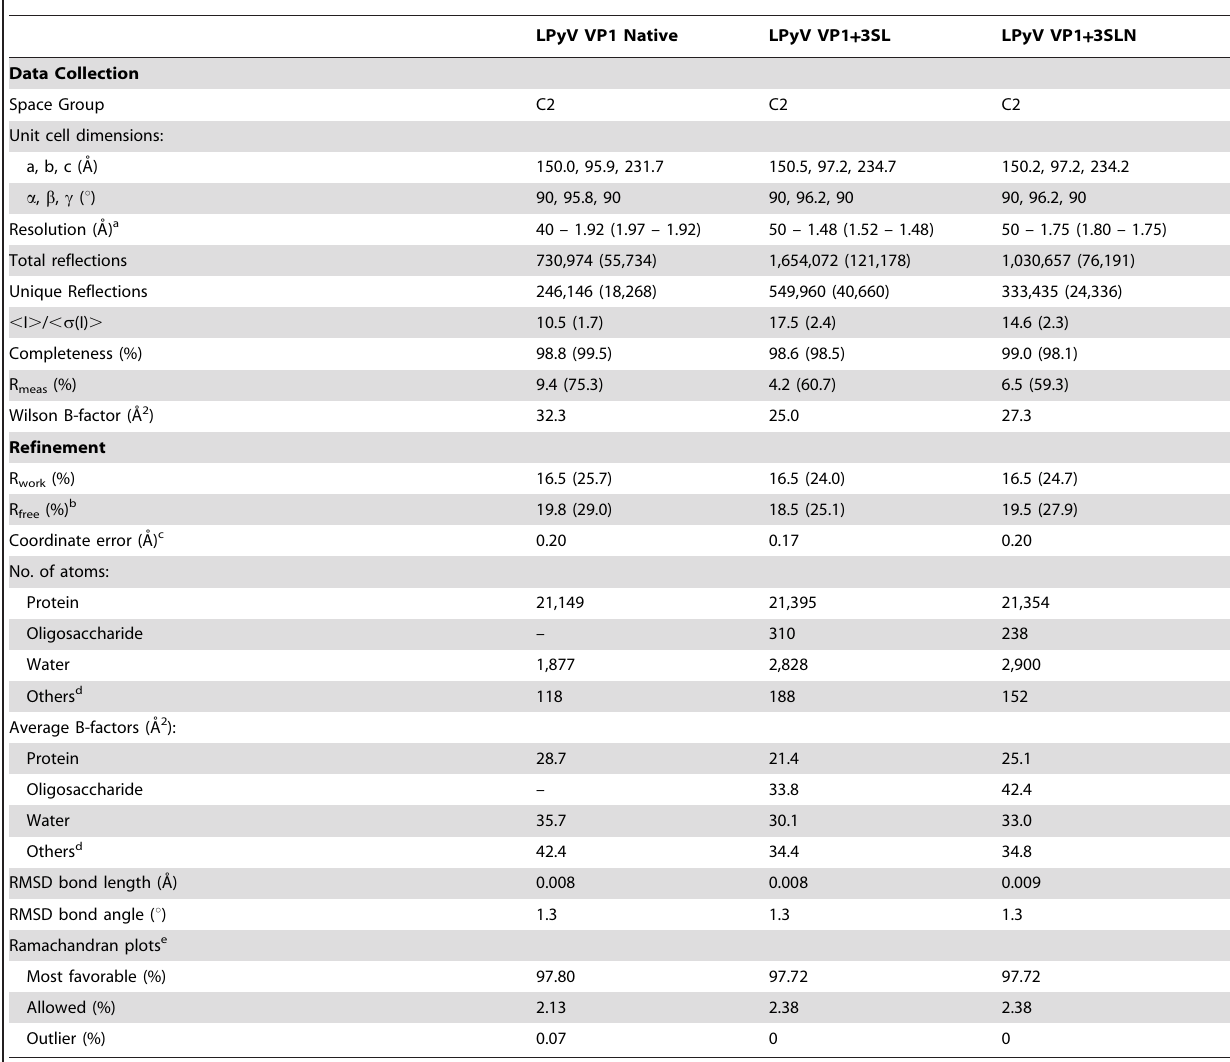
Table 1. Data collection and refinement